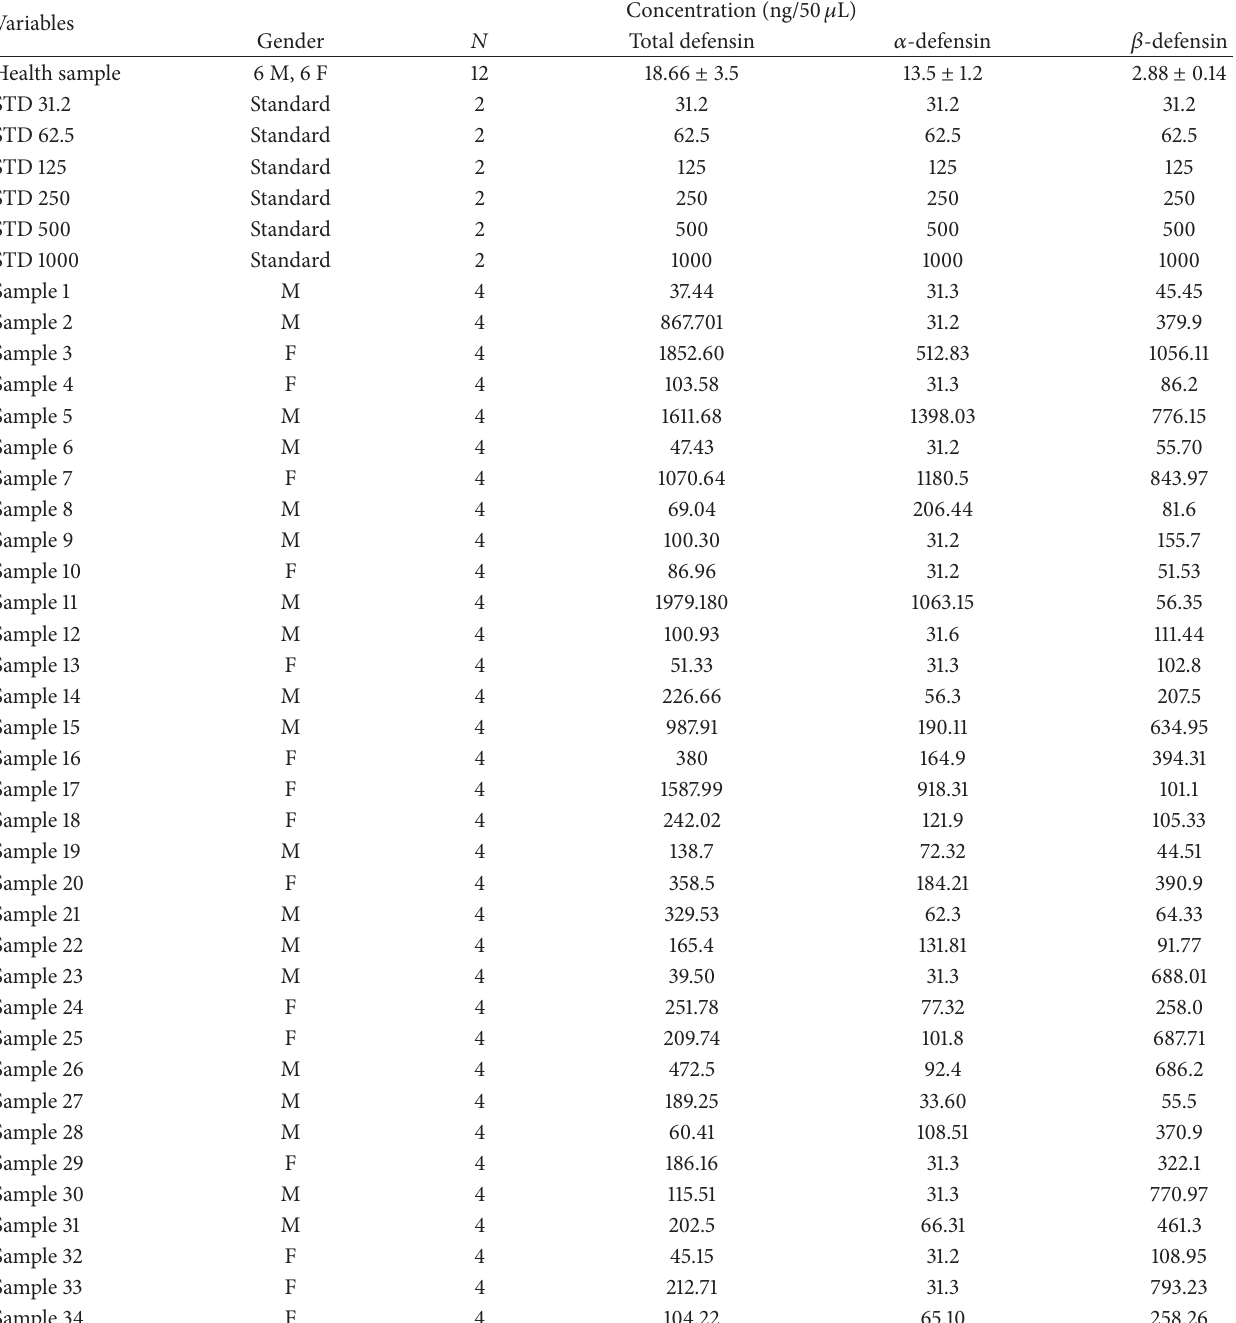
Table 4: Comparison between total, 𝛼 -, and 𝛽 -defensin concentration level in HCV patients